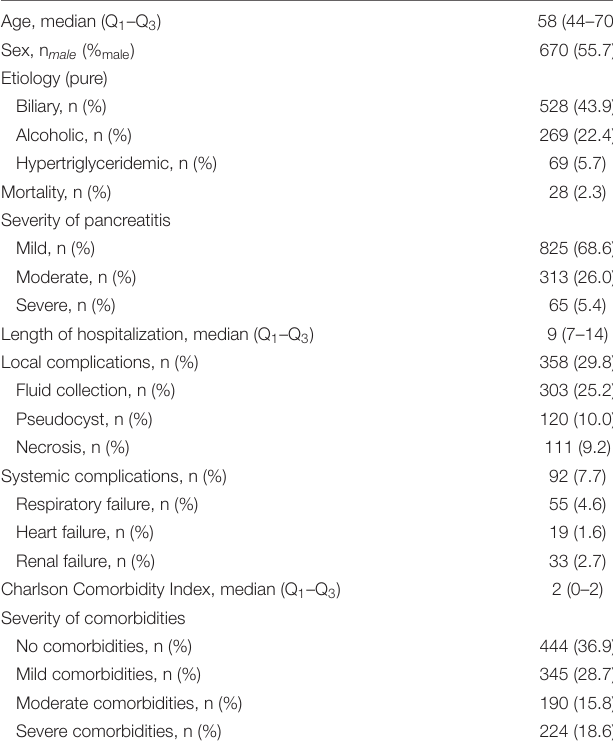
TABLE 1 | Demography of study population including a total of 1203 cases of acute pancreatitis